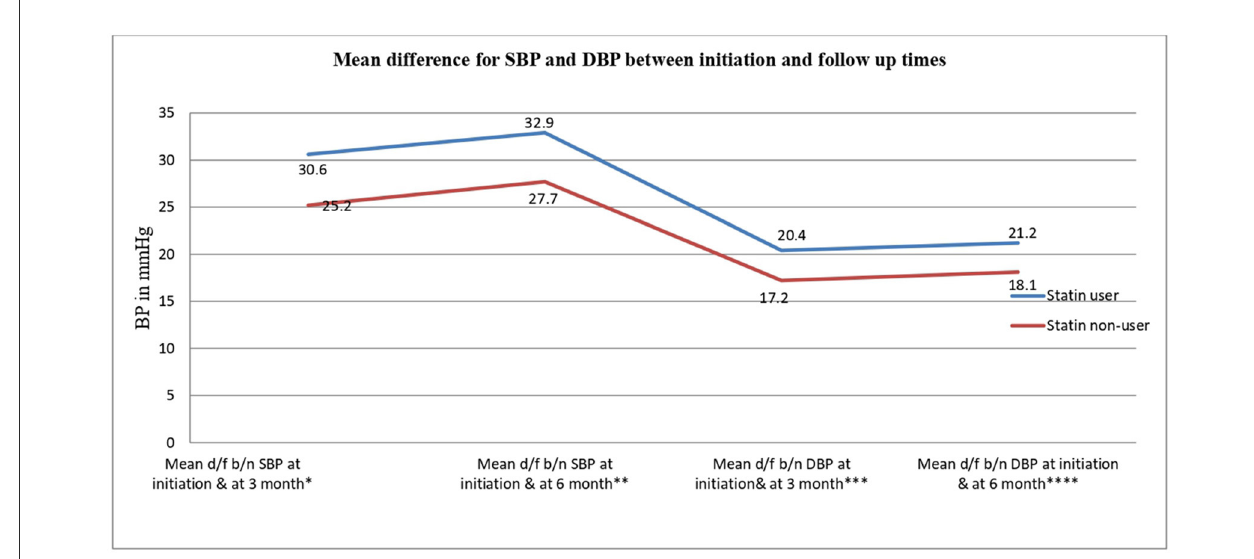
FIGURE2 Line graph showing the trend of blood pressure mean differences at various times between statin user and non-user hypertensive outpatients at the Felege Hiwot Comprehensive and Specialized Hospital, northwest Ethiopia. * Mean difference between systolic blood pressures at initiation and at 3 months. ** Mean difference between systolic blood pressures at initiation and at 6 months. *** Mean difference between diastolic blood pressures at initiation and at 3 months. **** Mean difference between diastolic blood pressures at initiation and at 6 months.